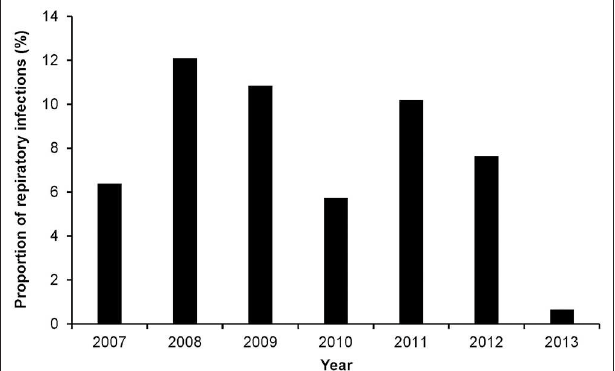
FIGURE 1 | Annual proportions of respiratory tract infections among dog samples tested at a referral veterinary teaching hospital in South Africa, 2007-2013.